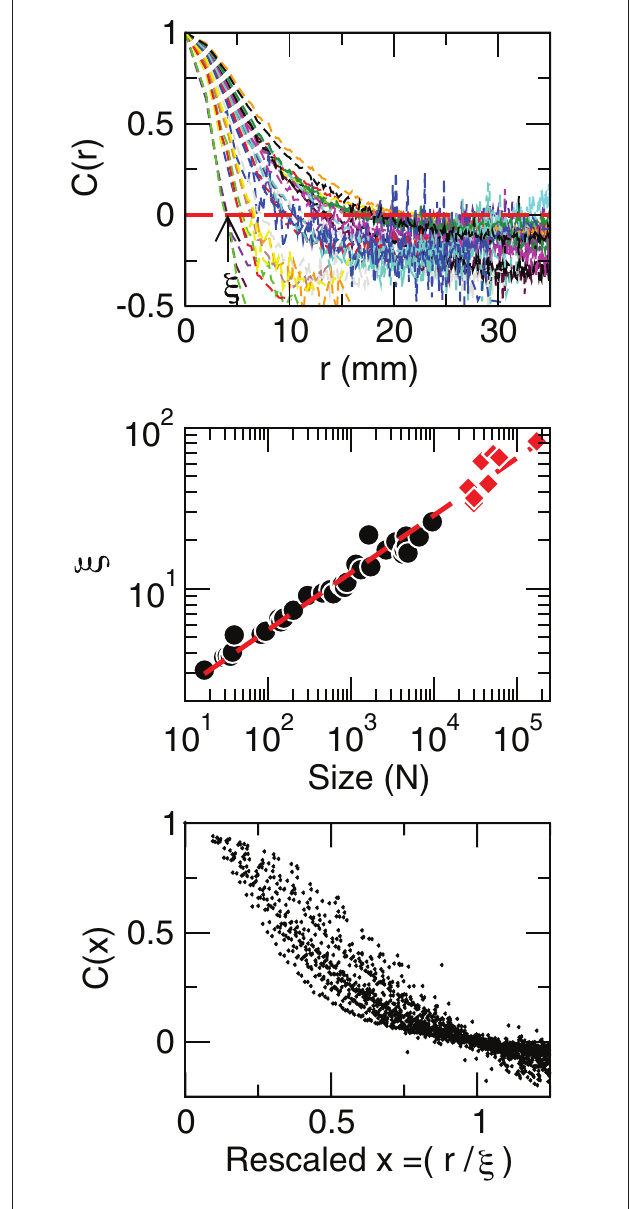
FIGURE 5 | Contrary to naive expectations, large clusters are as correlated as relatively smaller ones: the correlation length increases with cluster size. Each line in the top panel shows the mean cross-correlation C ( r ) of BOLD activity fluctuations as a function of distance r averaged over all time series of each of the 35 clusters shown in Figure 1 . The correlation length ξ , denoted by the zero crossing of C ( r ) is not a constant. The middle panel shows, in double log plot, the functional dependence ξ ∼ dN 1 / 3 , i.e., ξ grows linearly with the average cluster’ diameter d for all the 35 clusters (filled circles). The rightmost points (diamonds) corresponding to the ξ values computed for each of the eight RSN without any partitioning shows that the correlation length keep increasing up to the size of the brain (the dotted line is a guide to the eye with slope 1/3). The scale invariance is graphically illustrated by the bottom panel, where all C ( r ) data are replotted after rescaling the horizontal axis as x = r / ξ , showing a good overlap. Note that a perfect collapse of these curves can not be expected because of the severe anisotropy, imposed by the brain anatomy, affecting the estimation of the distance r